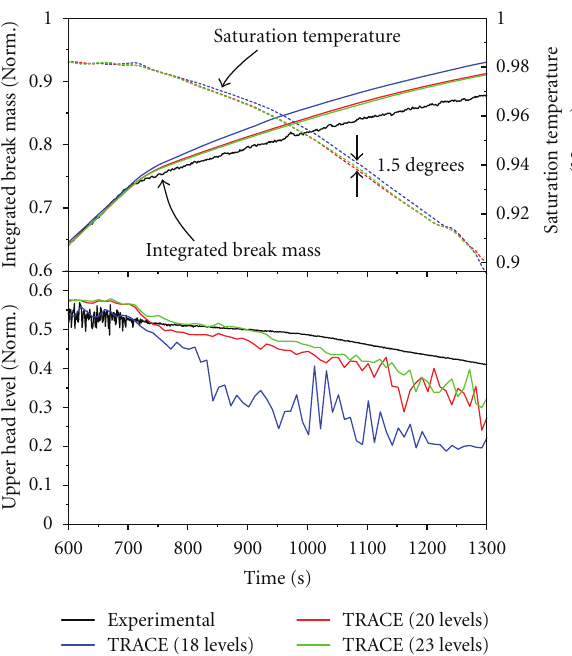
Figure 9: Sensitivity on the UH nodalization for Test 6-1 with finer and coarser meshing of the UH. Top: integrated break mass and saturation temperature at the top of the UH dome. Bottom: UH collapsed water level.